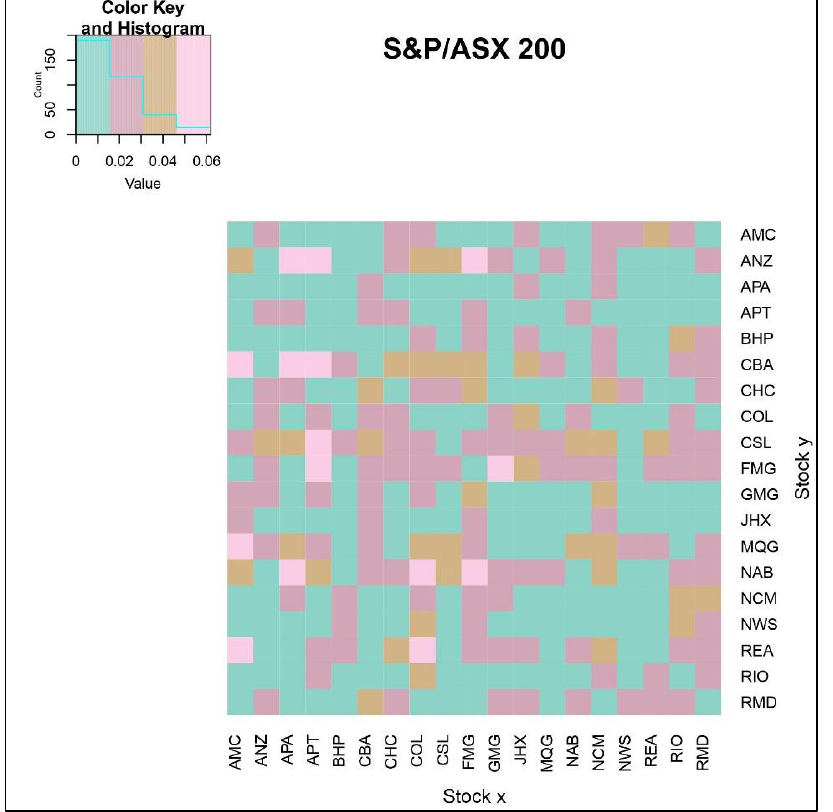
Figure 22. The information flow (effective transfer entropy) from stock y to stock x, for the top companies (by market capitalization) in the S&P ASX market, after the COVID-19